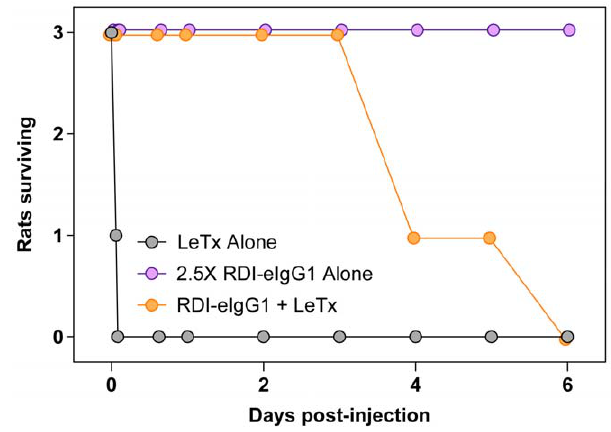
Figure 4. RDI-eIgG1 alone is not toxic in rats. Male 200 gram HSD rats (Harlan Laboratories, Indianapolis, IN) (3/group) were co-injected i.v. with LeTx (40 m g PA + 12 m g LF) alone or in combination with 49 ug RDI-eIgG1; or were dosed i.v. with 123 m g RDI-eIgG1 alone. Rats were monitored and time of death recorded.